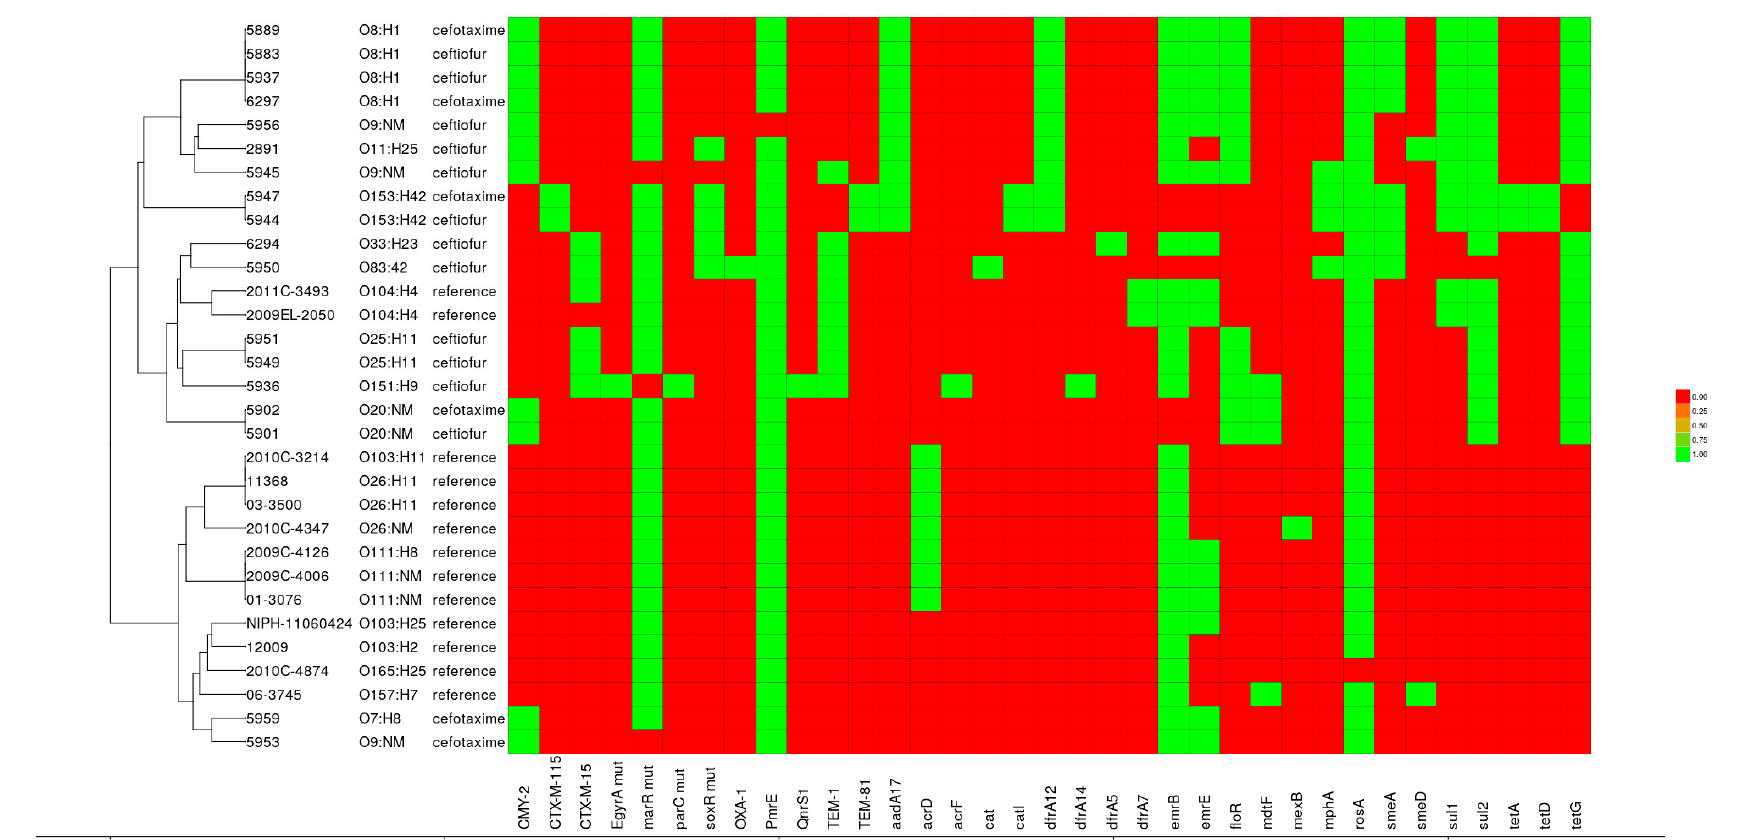
Figure 4. The heat map showing the presence (green color) and absence (red color) of antibiotic resistance genes (ARGs) across 18 TIO or FOX resistant and 14 pathogenic reference E. coli genomes. The bottom labels indicate the gene names. The tree on the left shows a hierarchical clustering of the labelled strains based on the genes profile.